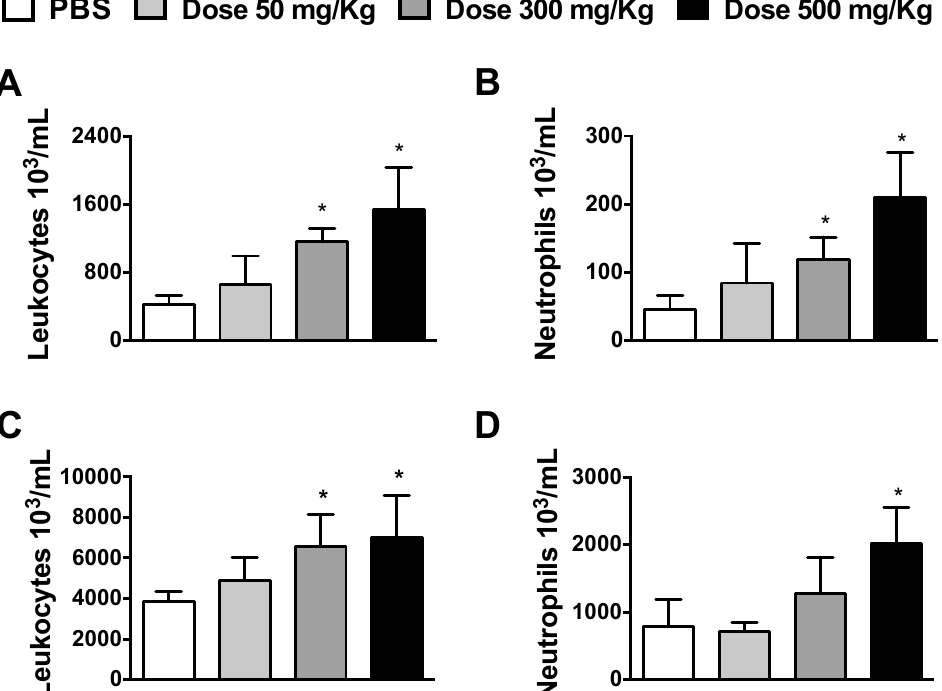
Figure 1. Alhe induces leukocyte accumulation into the peritoneal cavity and peripheral blood. Total leukocytes and neutrophils were evaluated after injection of 300 μ L of Alhe at different concentrations (50, 300, and 500 mg/kg) in the peritoneal cavity ( A , B ) or peripheral blood ( C , D ). The experiment was conducted twice using five mice per group (n = 10); the error bars denote ± SEM. * indicates control PBS versus different doses. These differences were considered significant when p < 0.05, according to ANOVA with Tukey’s post-test.